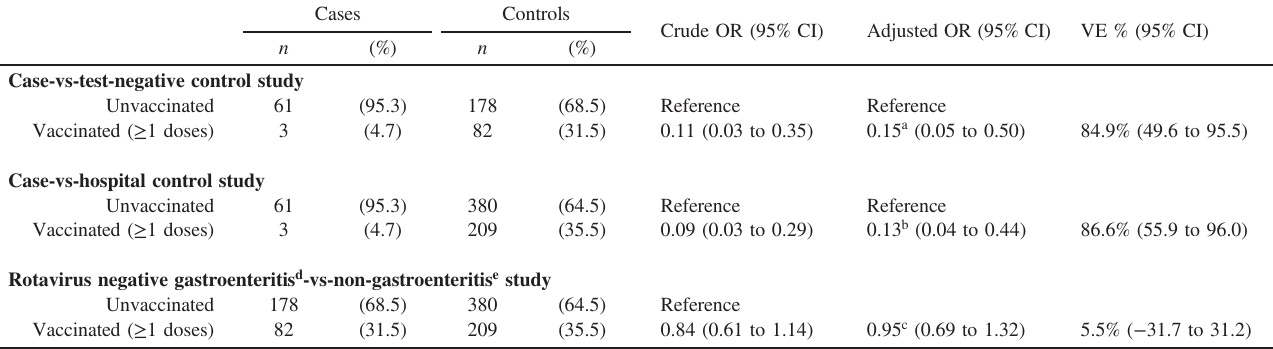
Table 3. Vaccine e ff ectiveness against rotavirus